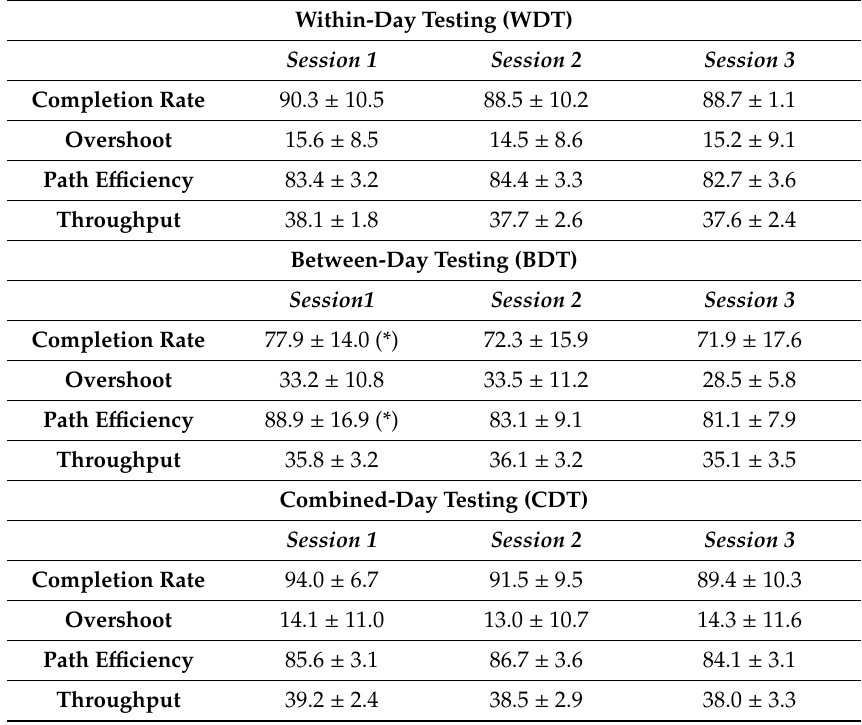
Table 5. Session wise di ff erence in all three control schemes. Results depict averaged performance over five days per session. Asterisks (*) indicate a case where there is a significant di ff